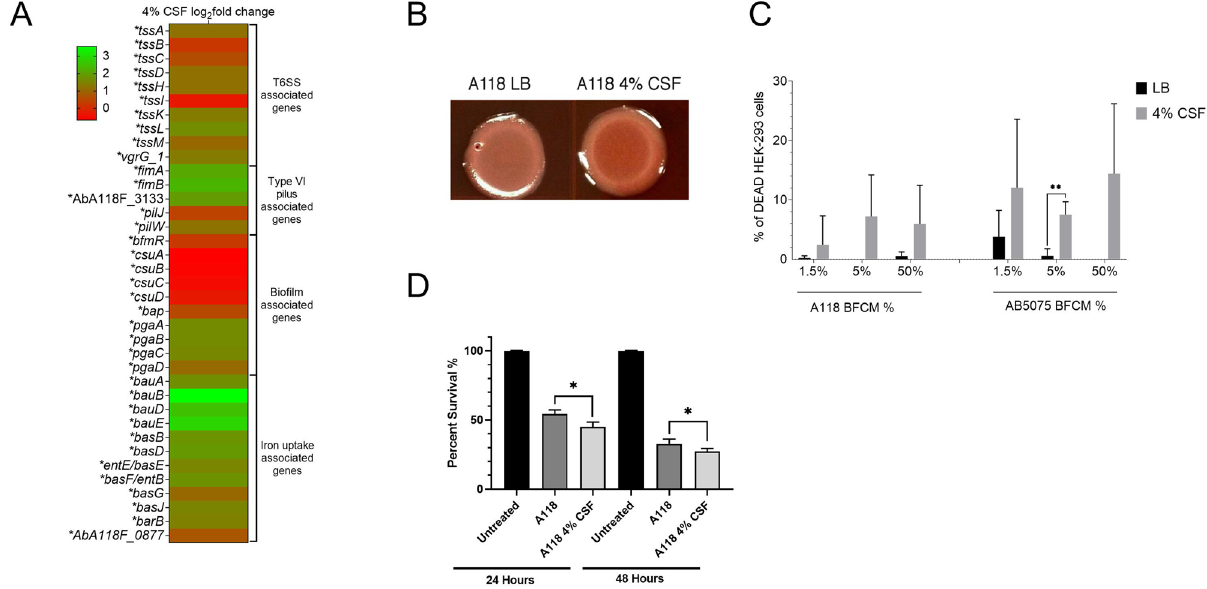
Figure 2. Exposure to CSF can affect multiple virulence factors in A. baumannii. (A ) Heat map of multiple virulence factor associated genes that were differentially expressed in A. baumannii strain A118. Asterisks represent a P-value of < 0.05. ( B ) Poly-N-acetylglucosamine (PNAG) assays were conducted with strains A118 in LB or LB supplemented with 4% CSF. ( C ) Percentage viability of HEK-293 cells under exposure to various concentrations of A. baumannii strains A118 or AB5075 supplemented with or without 4% CSF. ( D ) Percentage survival of Galleria mellonella when inoculated with A. baumannii strain A118 with or without 4%